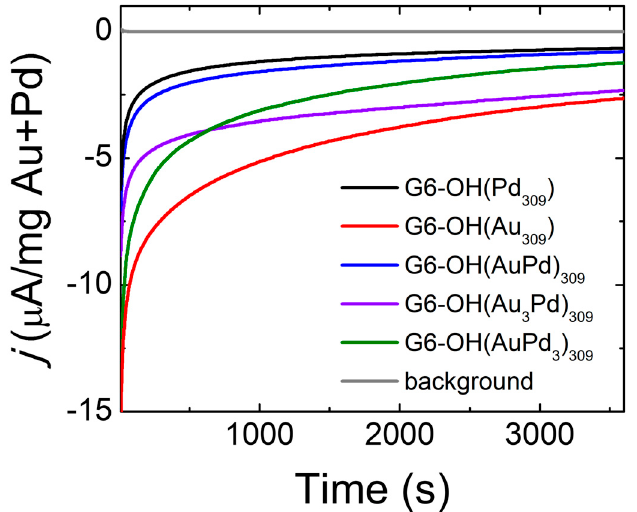
Figure 5. Electrocatalytic EOR CAs for the indicated DENs. The CAs were carried out in a N 2 ‐ satd., 1.0 M KOH solution containing 0.50 M ethanol, by holding the electrode potential for 1.0 h at the peak potential of the forward scan of the EOR CV. For clarity, the first 10 s of the CA are not shown in the figure.